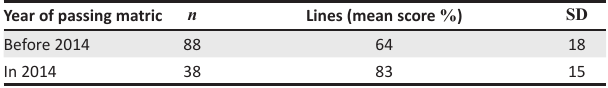
respect and they are to be trained at university entry level in order to reach the expected levels of the Van Hiele theory.